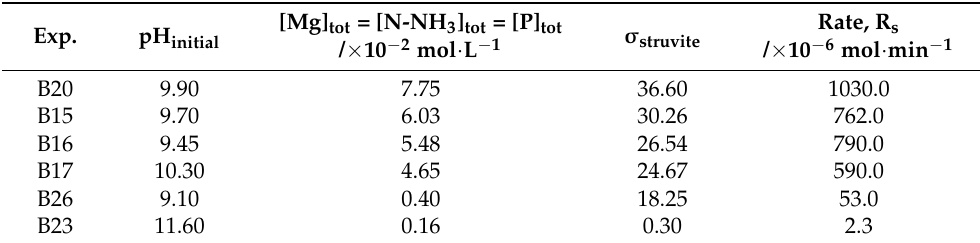
Figure 6. Spontaneous precipitation of struvite from aqueous supersaturated solutions prepared according to method B. Dependence of the rate of precipitation on the relative supersaturation with respect to struvite. 25 ◦ C. Table 3. Precipitation of struvite in its supersaturated solutions prepared according to method B. Initial pH value, magnesium concentration, Mg, relative supersaturation, σ and the corresponding rates measured for the experiments of Method B. 25 ◦